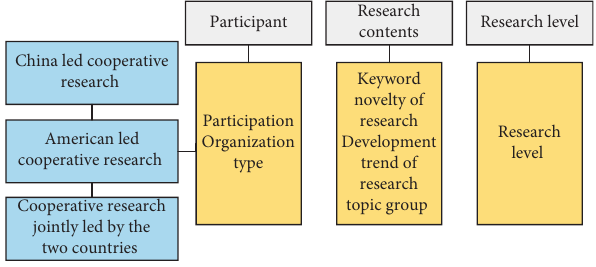
Figure 1: Matrix assessment